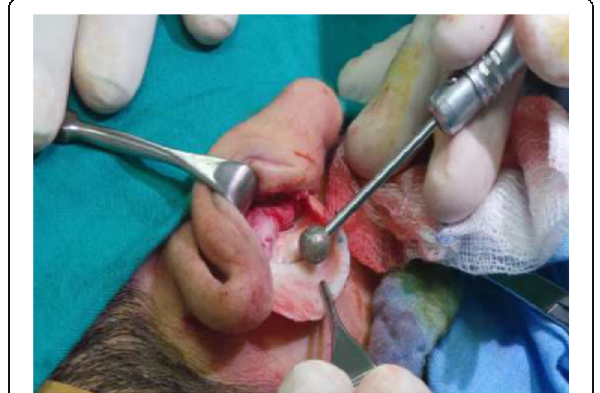
Fig. 5 After elevation of the anterior perichondrium, a diamond burring at the supposed site for the antihelical fold is designed at the weakening of the auricular cartilage and making it more malleable